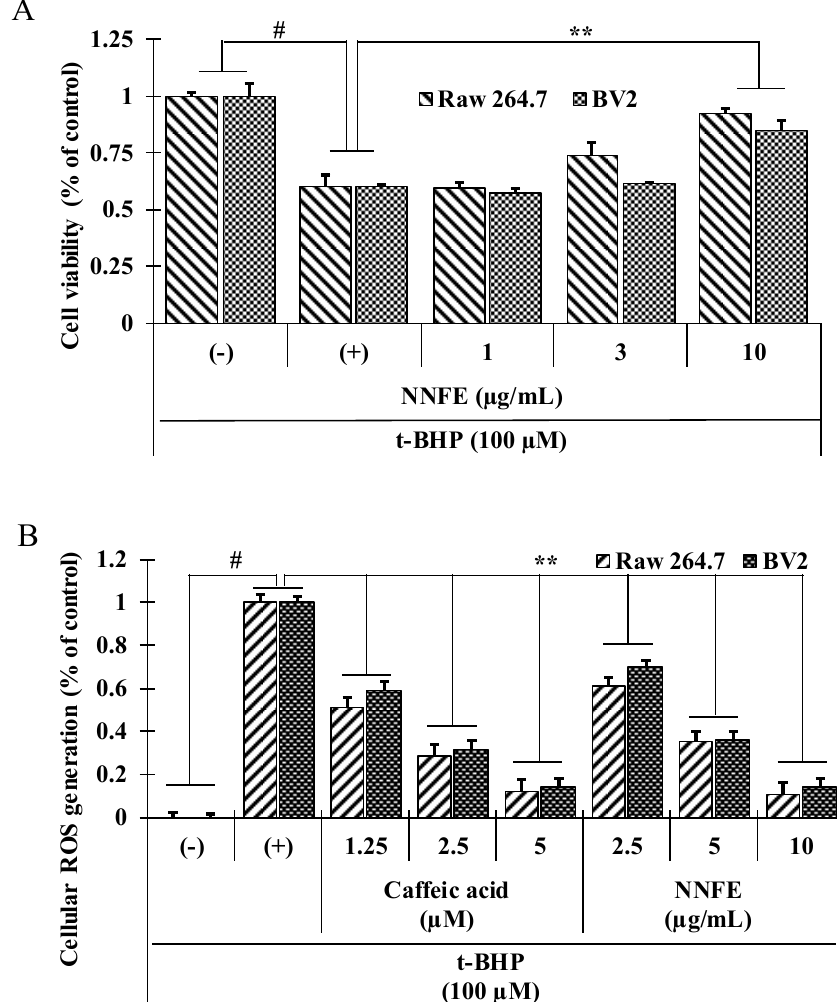
Figure 3. Protective effects of NNFE against tert -Butyl hydroperoxide ( t -BHP) induces cell viability and intracellular reactive oxygen species (ROS) generation. Cells were treated with NNFE (1–10 µ g/mL) for 12 h and then exposed to 100 µ M t -BHP for 12 h, and cell viability percentage was determined by 3-(4,5-dimethylthiazol-2-yl)-2,5-diphenyltetrazolium bromide (MTT) assay for RAW 264.7 cells and BV2 cells ( A ). Cells were treated for 12 h with the indicated concentrations of NNFE and caffeic acid before treatment with 100 µ M t -BHP. Intracellular ROS was measured by monitoring the dichlorodihydrofluorescein (DCF) fluorescence intensity for RAW 264.7 cells and BV2 cells ( B ). Values are expressed as the mean ± SD ( n = 3). # p < 0.001 compared to control, ** p < 0.05 compared to t -BHP treatment. Statistical analysis was carried out using student’s t -test. ( − ): no treatment (+): treatment with t -BHP.